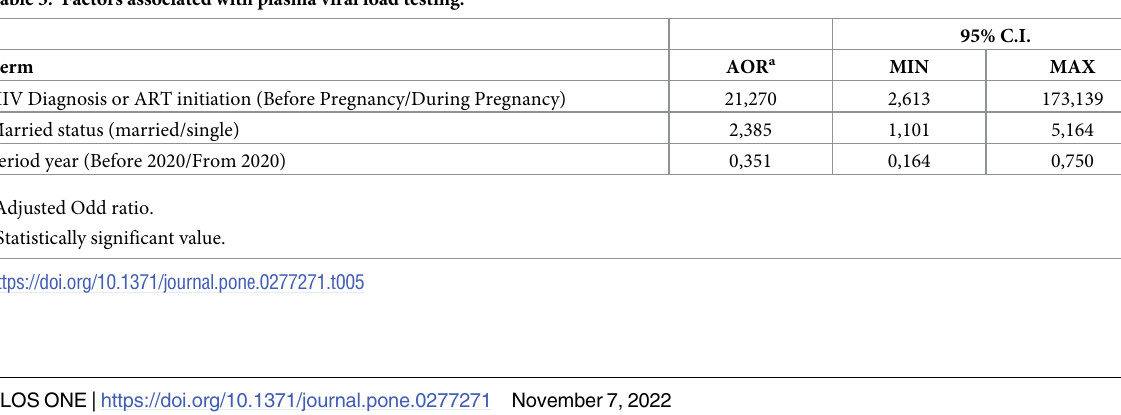
Table 5. Factors associated with plasma viral load testing.